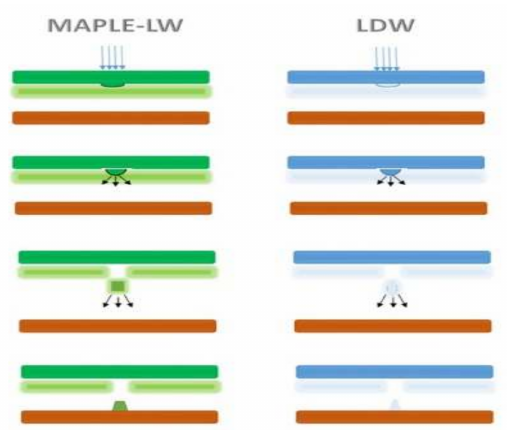
Figure 5. Schematic presentation of LDW mechanisms. ( Left ) In matrix-assisted pulsed laser evapo- ration direct-write (MAPLE-DW): the laser is absorbed by the matrix (not shown), which is removed after deposition. ( Right ) LDW printing of rheological systems: the thin layer absorbs the laser near the substrate and pushes the remaining ink forward (reproduced after